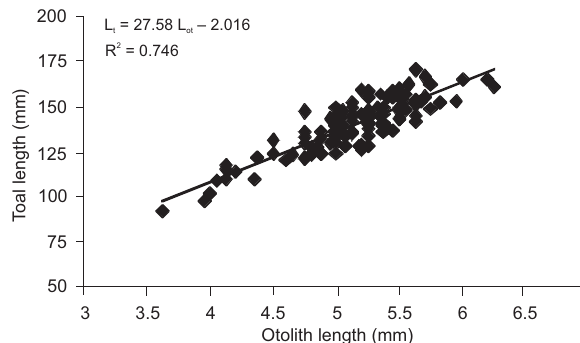
Figure 3. Relationship between the otolith size (mm) and total length (mm) of C. edentulus individuals from Saco dos Limões bight (southern